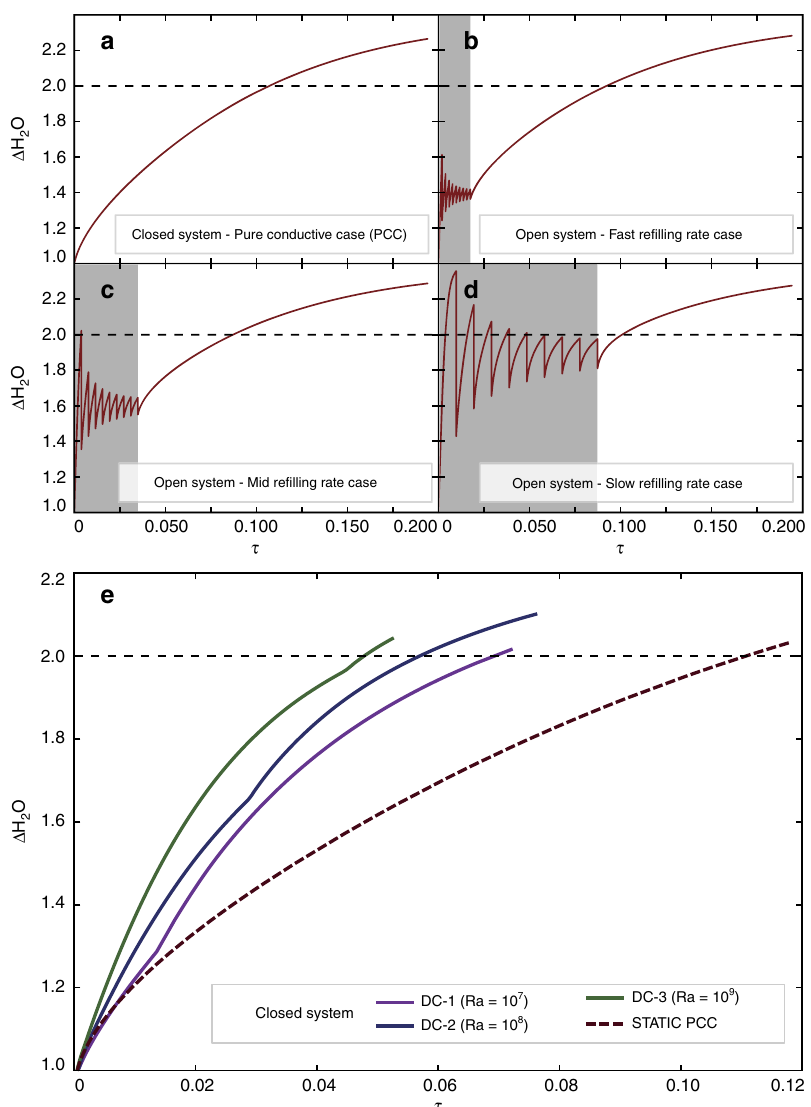
Fig. 3 Temporal evolution of water concentration in the melt phase. Evolution of the Δ H 2 O parameter (i.e., the ratio between the current H 2 O concentration in the residual melt and its initial value) over the non-dimensional time τ , calculated as τ = t α / L 2 , for: a closed system in static conditions (i.e., convective dynamics do not develop within the system), b open system periodically re fi lled by new magma at fast-re fi lling rates; c open system periodically re fi lled by new magma at mid-re fi lling rates; d open system periodically re fi lled by new magma at slow-re fi lling rates; e closed system characterized by the development of buoyancy-driven convective motions. Three dynamical cases are reported for Rayleigh numbers equal to 10 7 (DC-1), 10 8 (DC-2), and 10 9 (DC-3). The pure conductive case (PCC) of a is also reported as